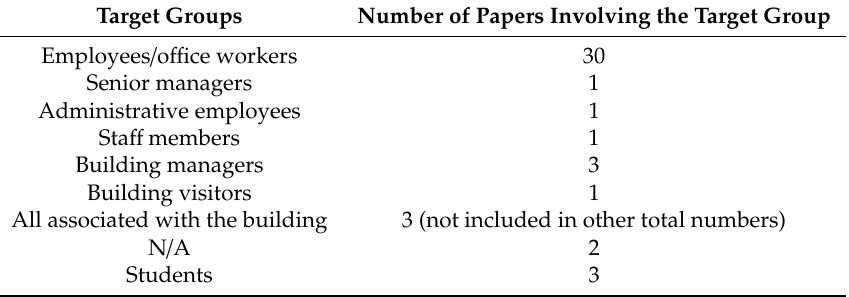
Table 3. Target groups assessed in public buildings.